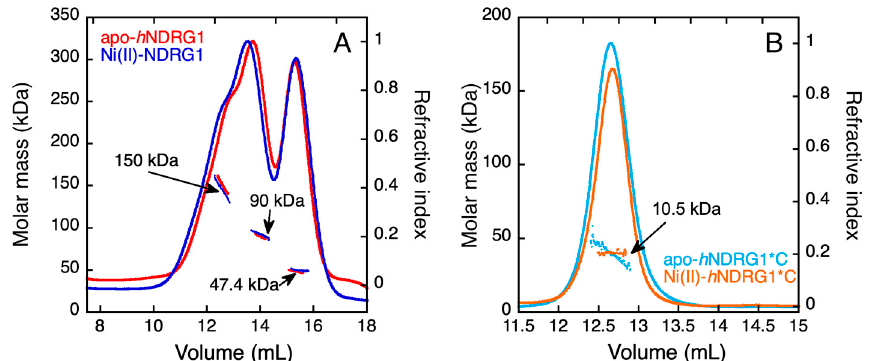
Figure 10. Molar mass and hydrodynamic radius determined by static and dynamic light scattering in line with a size-exclusion chromatography column. The chromatogram represents the trace of refractive index detector (lines) and the weight-averaged molar mass distribution, calculated on the eluting species, is represented as dots. The profile of h NDRG1 ( A ) and of h NDRG1*C ( B ) is reported in the absence and in the presence of four equivalents of Ni(II).